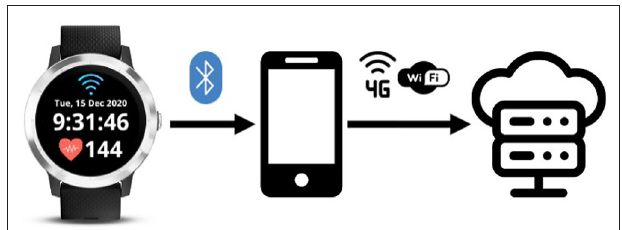
FIGURE 1 | Diagram illustrating the infrastructure implemented to collect the harAGEdataset and the technologies used to transfer the data between the involved nodes. The front-end design of the customized smartwatch app is depicted on the